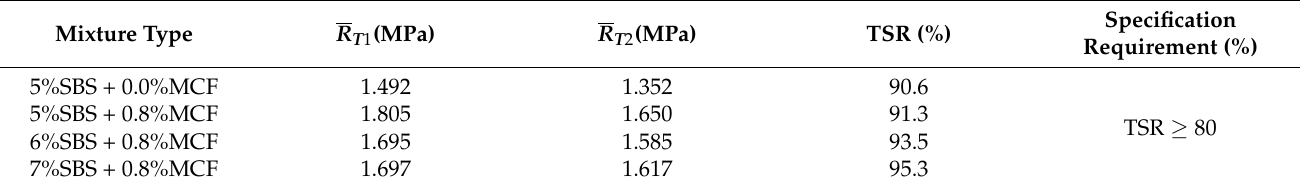
Table 9. Results of the freeze–thaw splitting